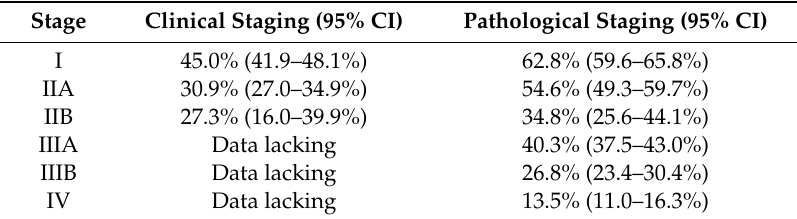
Table 3. Five-year overall survival with confidence interval (CI)